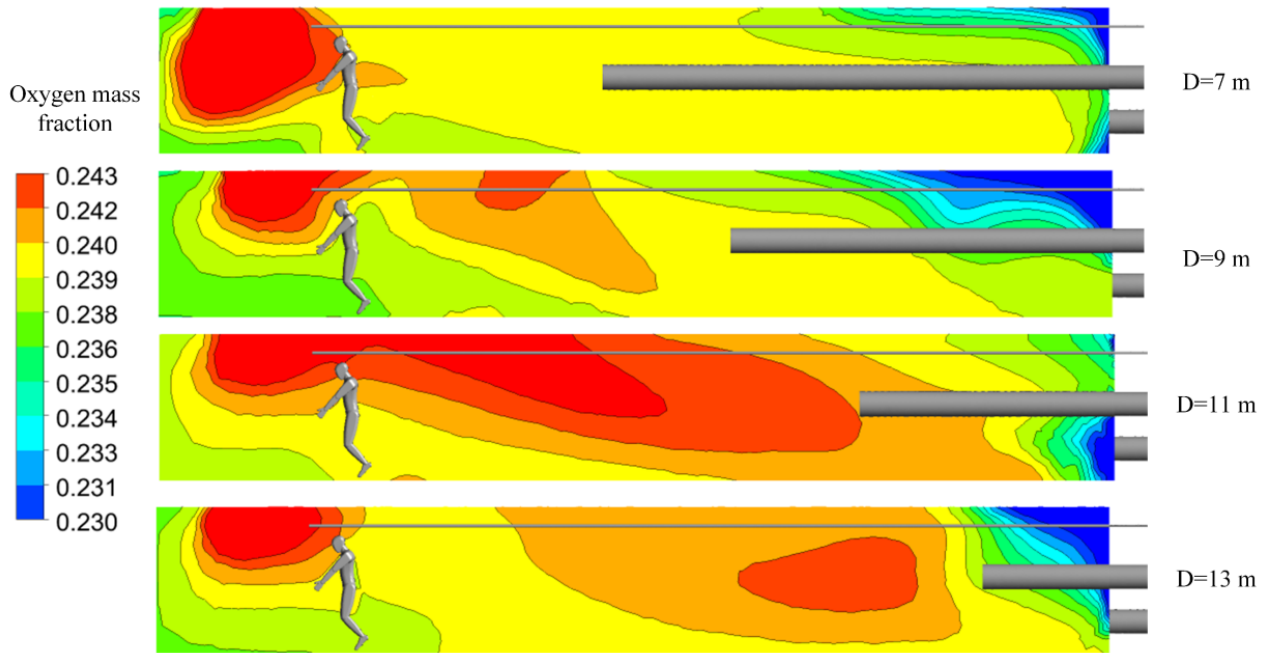
( a ) ( b ) Figure 10. Characteristic diagrams of oxygen mass fraction distributions in the main working area. ( a ) Oxygen mass fractions along the roadway; ( b ) oxygen mass fractions in the respiratory zone and in the entire workspace. 4.2. Exhausting Duct Position The position of the exhausting duct has a direct influence on the airflow field and pressure in the roadway, and thus influences the oxygen distribution in the blind heading face. Therefore, the effects of the height between the exhausting duct and the roadway floor in addition to the distance between the exhausting duct inlet and blind heading face on oxygen enrichment were considered in this study. 4.2.1. Height between Exhausting Duct and Roadway Floor In order to study the effect of the height between the exhausting duct and the blind heading face on local oxygen enrichment, the heights of 0.3 m, 0.5 m, 0.7 m, and 0.9 m were selected for the calculations; the other setting conditions were maintained consistent with Case 3. Figure 11 shows that with an increase in the height between the exhausting duct and the roadway floor, the distribution range of high-concentration oxygen first expanded and then decreased. When the height between the exhausting duct and roadway floor reached